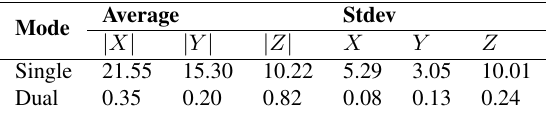
Table 1. Accuracy comparison of bundle adjustment (in meters).